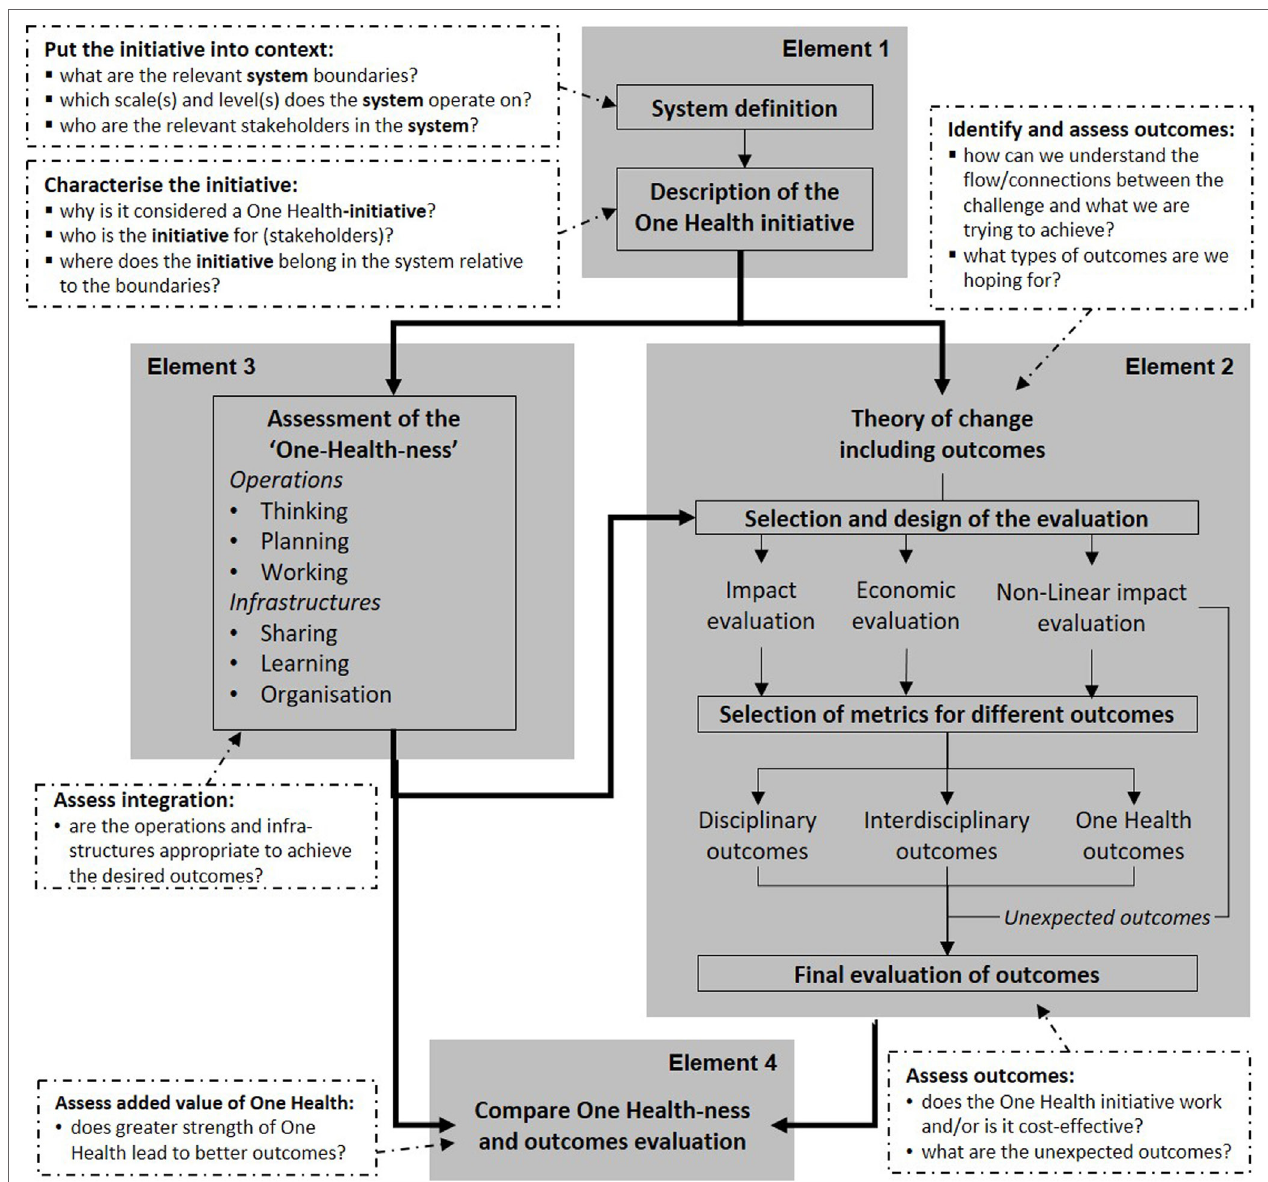
FIgURe 1 | Flow chart of Elements to be considered during a One Health (OH) evaluation (in grey) with their purpose and the associated questions to be answered (white boxes). In Element 1, the initiative and its context are described to inform Elements 2 and 3. Element 2 relies on a theory of change to identify expected outcomes and collects unexpected outcomes through non-linear impact assessment. In Element 3, the implementation of operations and infrastructure contributing to the OH initiative is assessed. The two assessments are compared in Element